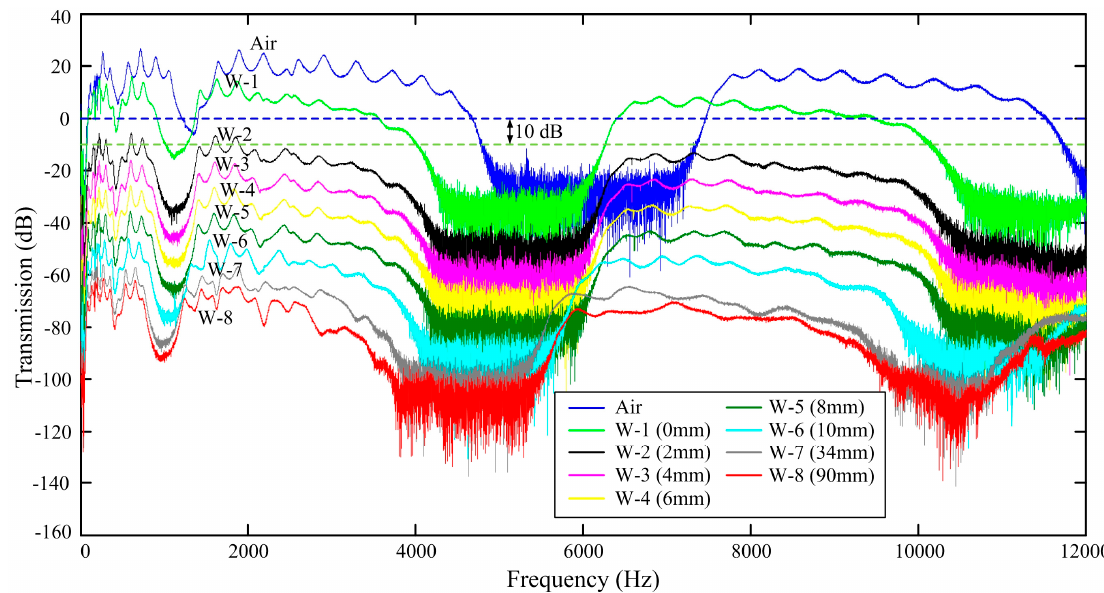
Figure 6. Shifts of the displacement transmission with different immersed depths (color online).